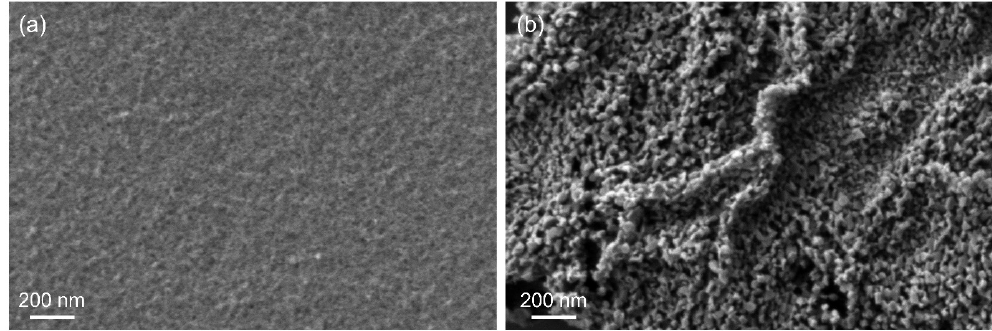
Figure 4. SEM images of two example layers of ( a ) Al 2 O 3 and ( b ) MgO prepared by pre-mixing the polymer ((a): 200 mg; (b): 150 mg) with the metal salts ((a): 600 mg Al(NO 3 ) 3 ∙9H 2 O; (b): 450 mg Mg(NO 3 ) 2 ∙6H 2 O) prior to spin-coating and subsequent photo-cross-linking and calcination.